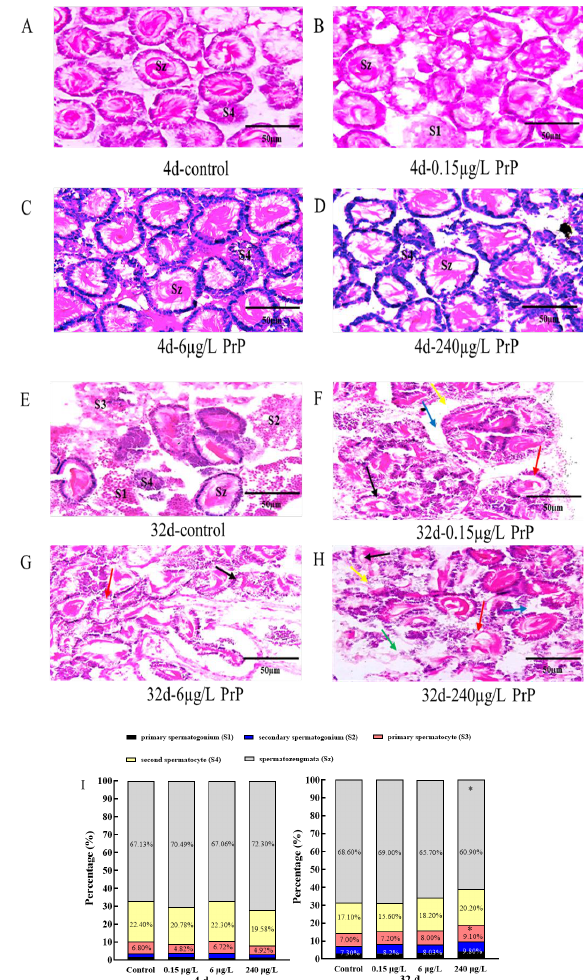
Figure 3. The testes histopathology of male mosquitofish from the control (( A ): 4d and ( E ): 32d), 0.15 µ g/L PrP group (( B ): 4d and ( F ): 32d), 6 µ g/L PrP group (( C ): 4d and ( G ): 32d) and 240 µ g/L PrP group (( D ): 4d and ( H ): 32d). Bars = 50 µ m, n = 20. S1: primary spermatogonium, S2: secondary spermatogonium, S3: primary spermatocyte, S4: second spermatocyte, Sz: spermatozeugmata. Black arrows: spermatorgenic cell lesion; Red arrows: decreased mature seminal vesicle count; Yellow arrows: sperm cells aggregation; Green arrows: seminiferous tubules disorder; Blue arrows: dilated intercellular space. ( I ): Percentage of different germ cells in the male mosquitofish exposed to different concentrations of PrP for 4 d and 32 d. The proportion of germ cells at different developmental stages were analyzed in 100 cells of each fish. Asterisks (*) above the bars indicate statistical significance of the germ cells ratios in the male fish suffered from PrP with the same dose between 4d and